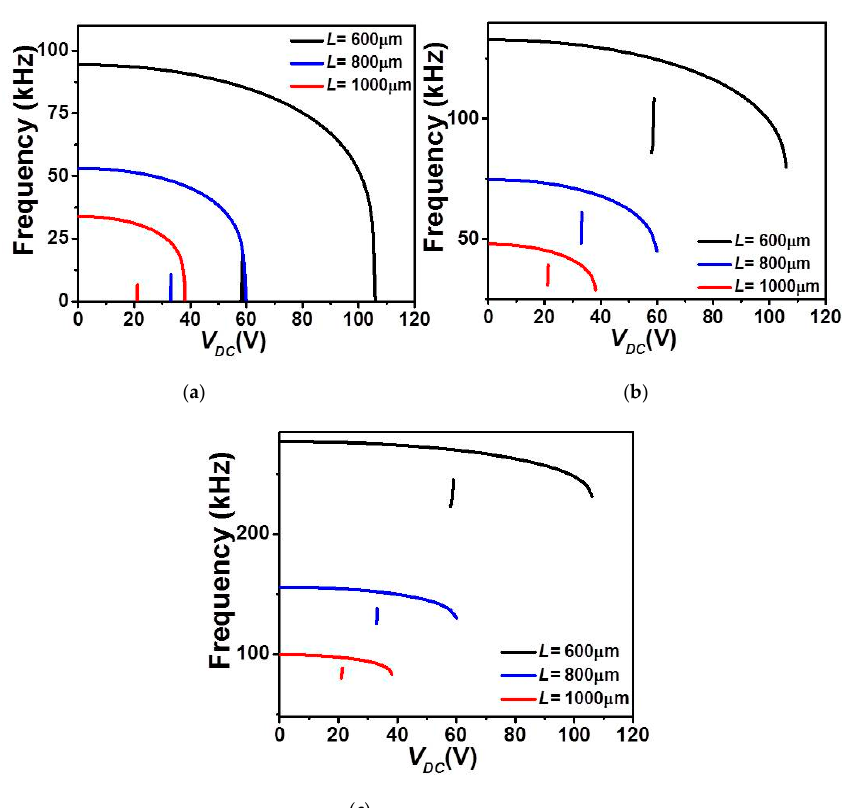
Figure 9. The variation of the ( a ) first, ( b ) second, and ( c ) third in-plane flexure natural frequencies for Case 1 as varying V DC with uniform g and for various values of L.